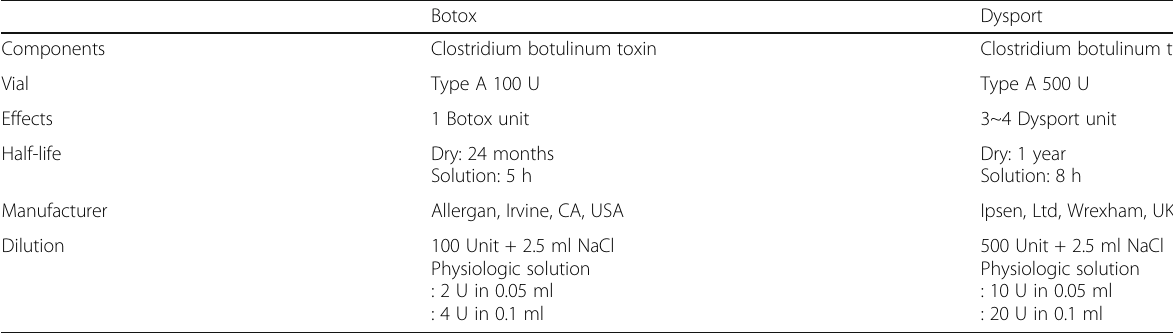
Table 1 Comparison of Botox and